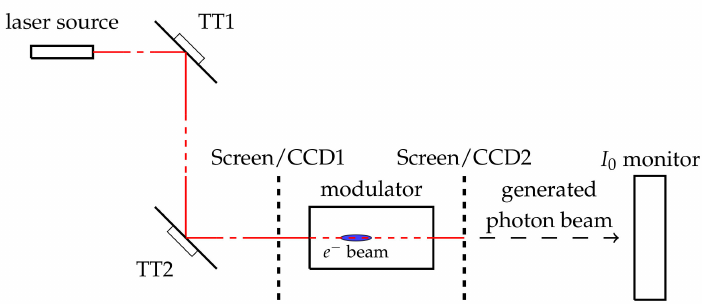
Figure 2. Simple scheme of the FERMI FEL seed laser alignment set up. TT1 and TT2 are the tip-tilt mirrors, Screen/CCD1 and Screen/CCD2 are the two removable YAG screens with CCDs and I 0 monitor is the employed intensity